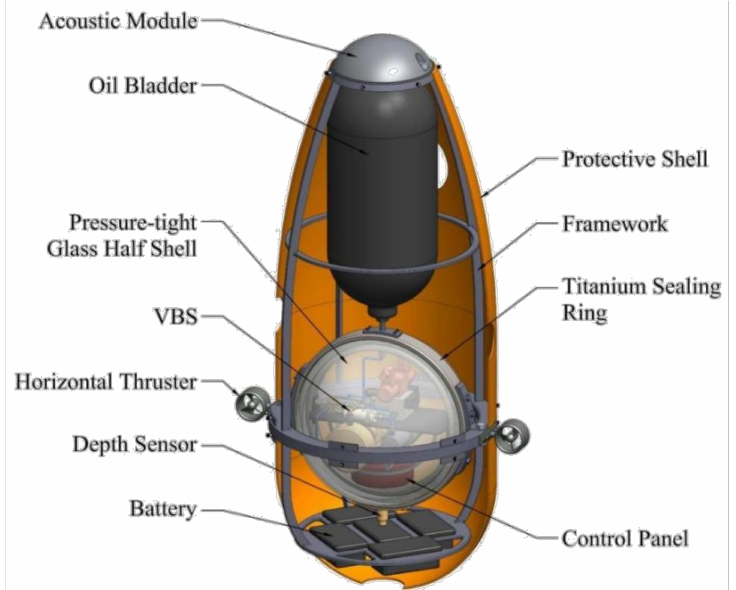
Figure 1. Inner view of deep-sea AUV.